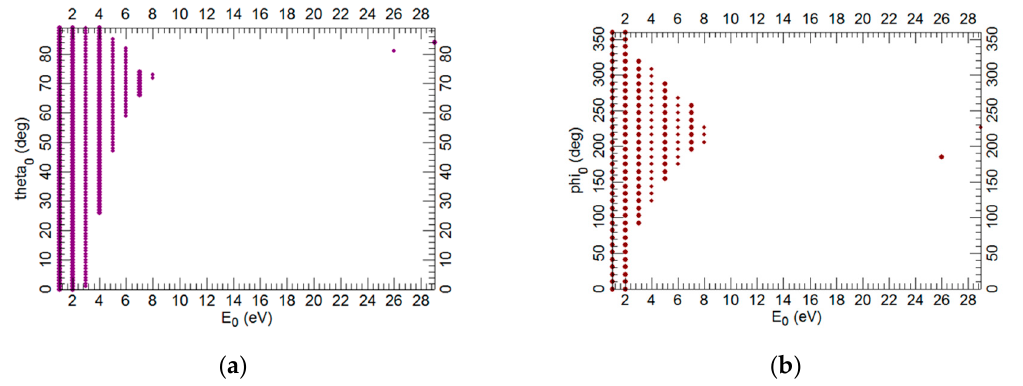
Figure 4. Acceptance diagrams. The initial polar angle theta 0 ( a ) and initial azimuthal angle phi 0 ( b ) as a function of the initial energy of electron E 0 , E P = 1 keV, WD = 1 mm, U SB = + 4 V.